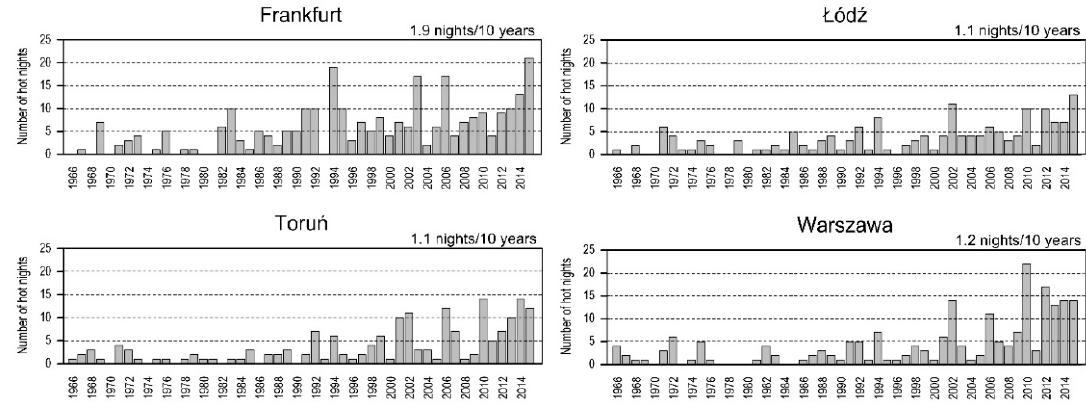
Figure 2. Number of hot nights in the summer in the period 1966–2015 in selected stations.